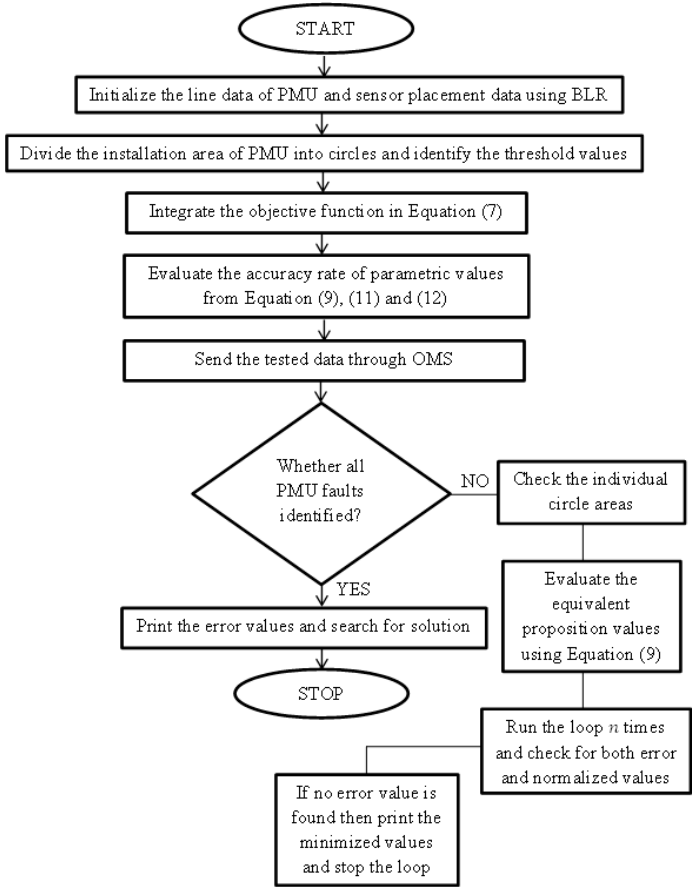
Figure 2. Flow chart of Binary Logistic Regression (BLR) .